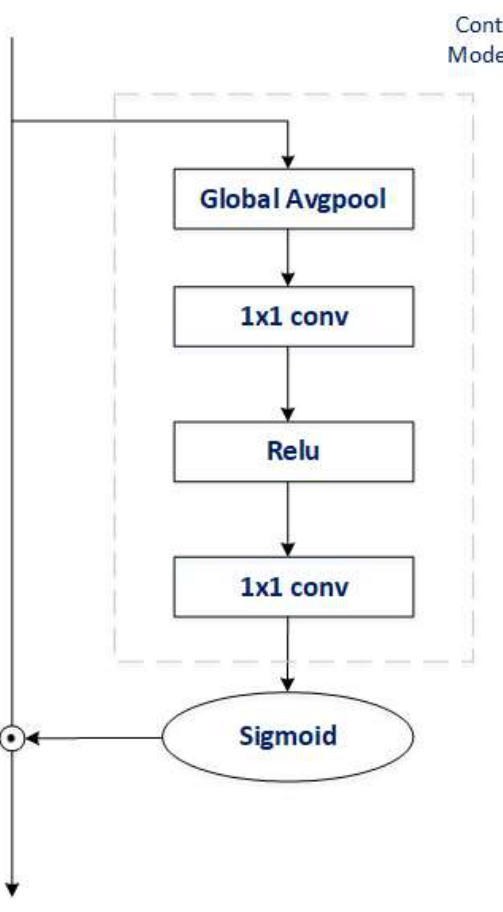
Figure 3. Attentional Simplification Chart.